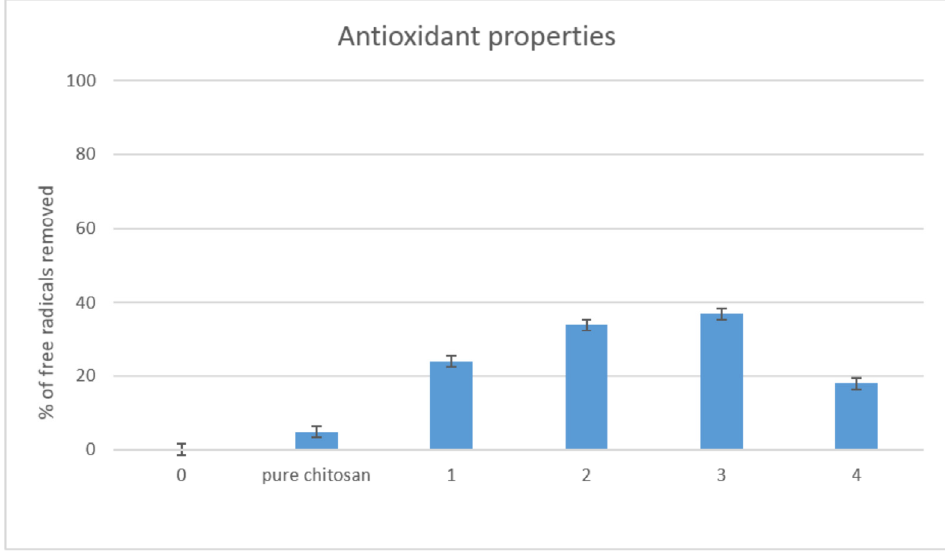
Figure 7. Antioxidant properties study.